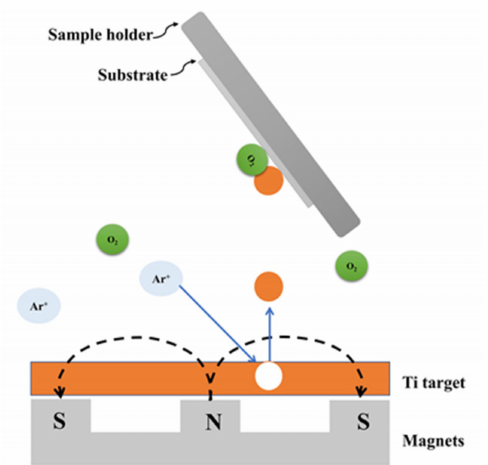
Figure 6. Schematic representation of the reactive sputter deposition process with OAD configuration. Oxygen atoms, originating from O 2 gas molecules, can react with sputtered Ti atoms on the substrate to form a TiO 2 film. The magnetic field (generated by the magnets) produces a force on the electrons, which keeps them on a helical path close to the target for relatively long times. In this way, very low sputtering gas pressures can be used together with an OAD configuration to allow the ejection of atoms to reach the substrate in an oblique direction.